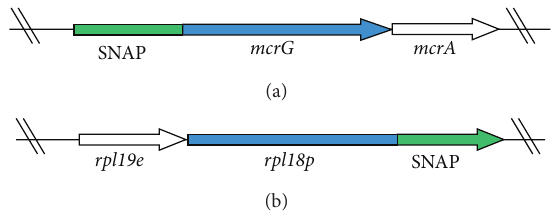
Figure 1: Genetic constructs showing position of SNAP relative to our protein of interest on chromosome of M. acetivorans . (a) N- terminal label on mcrG gene. (b) C-terminal label on rpl18p gene.